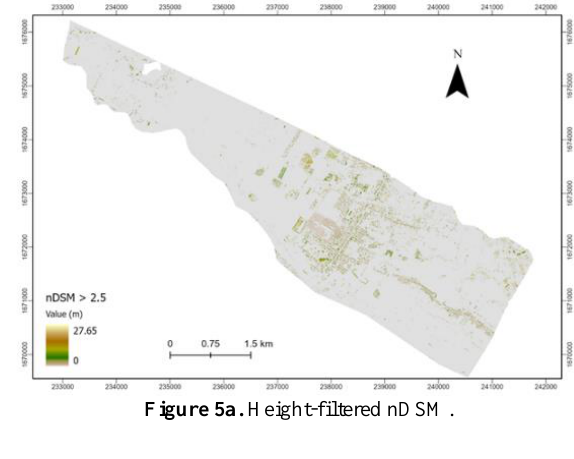
Figure 5a. Height-filtered